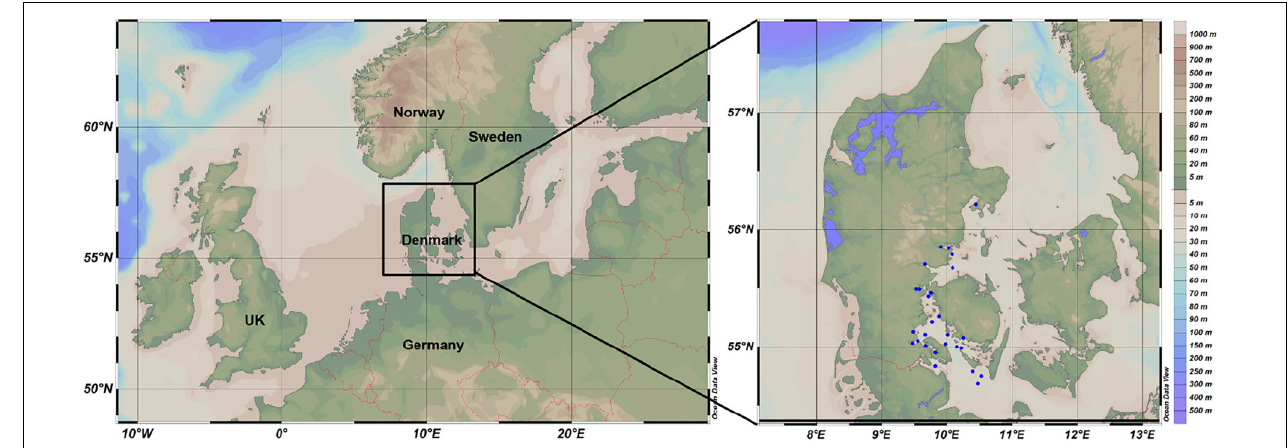
FIGURE 1 | Sampling stations of the NOVANA monitoring program considered in this study (autumn 2017 and spring 2019).